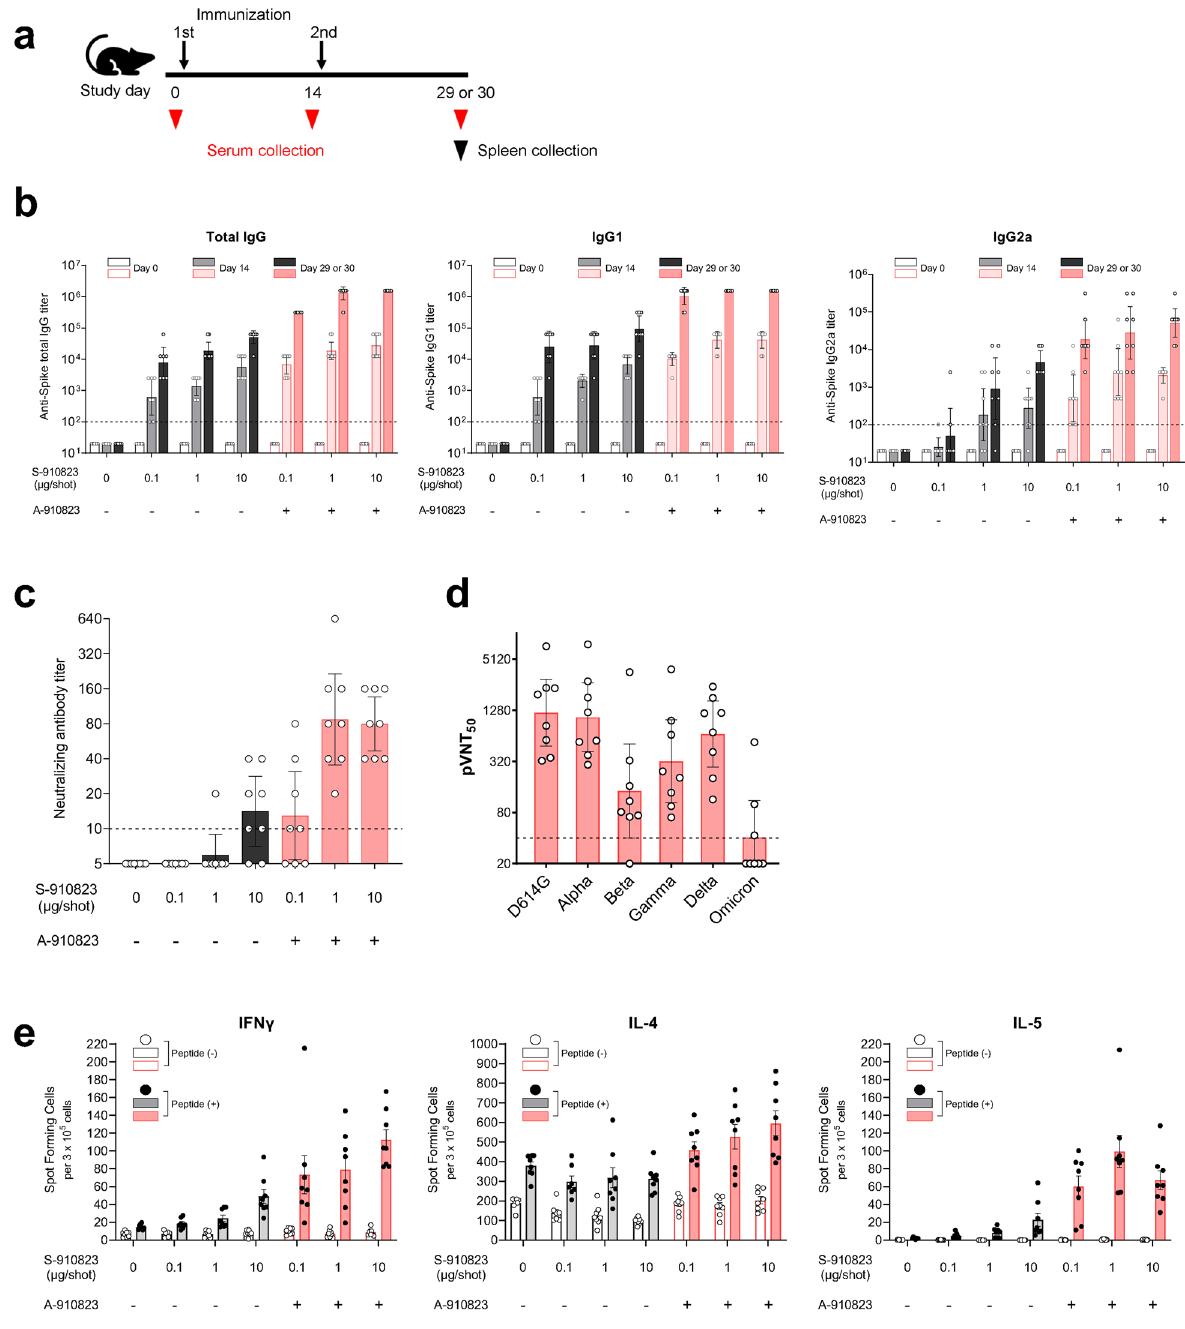
Figure 1. Immunogenicity of S-910823 plus A-910823 in mice after intramuscular dosing. ( a ) Study schedule schematic. ( b ) Antigen-specific total IgG, IgG1, and IgG2a titers in the serum were measured using enzyme- linked immunosorbent assays. Each bar represents the geometric mean titer (error bars indicate a 95% confidence interval). Each circle represents the titer in an individual mouse. Dotted lines indicate the lower limit of detection. ( c ) Serum titers of neutralizing antibodies against severe acute respiratory syndrome coronavirus 2 (SARS-CoV-2). Each bar represents the geometric mean titer (error bars indicate a 95% confidence interval). Each circle represents the neutralizing antibody titer in individual mice. The dotted line indicates the lower limit of detection. ( d ) Serum titers of neutralizing antibodies against SARS-CoV-2 spike pseudotyped lentivirus in mice administered 1 μg of S-268019-b. Each bar represents the geometric mean titer (error bars indicate a 95% confidence interval). Each circle represents the neutralizing antibody titer in individual mice. The dotted line indicates the lower limit of detection. ( e ) The number of cytokine-secreting cells in the spleen of immunized mice was determined using enzyme-linked immunospot analysis. Each bar represents mean spot-forming cells (SFCs) (error bars indicate standard error of mean). The open and solid bars indicate non-stimulated splenocytes and splenocytes stimulated with SARS-CoV-2 spike-protein peptides, respectively. The gray bars represent mice administered S-910823 without A-910823, while the rose bars represent mice administered S-268019-b. The open and solid circles represent the results of individual